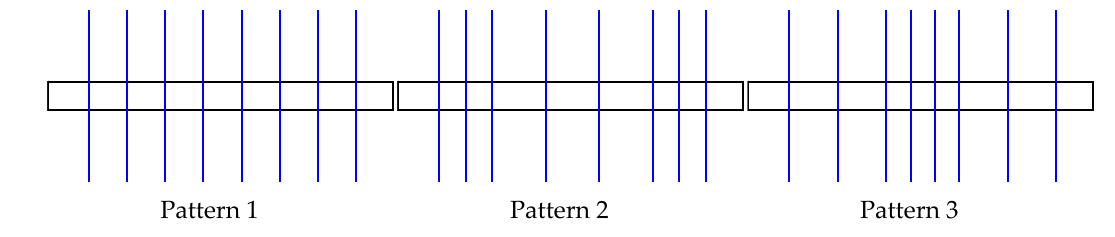
Figure 14. Schematic of different fracture spacing patterns.